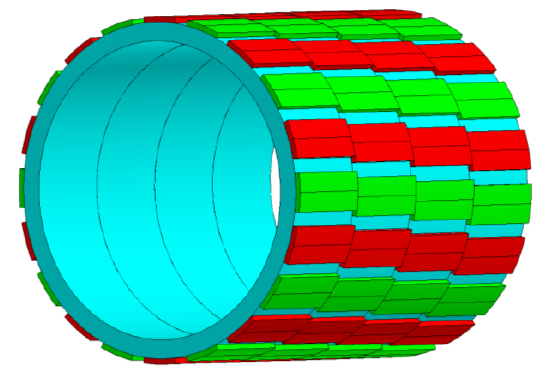
Energies 2018 , 11 , x FOR PEER REVIEW Figure 14. Fractional skewing in the rotor. Figure 14. Fractional skewing in the rotor. Table 4. Comparison of the maximum cogging torque values of PMSG with centered holes and the different models considering skewing.